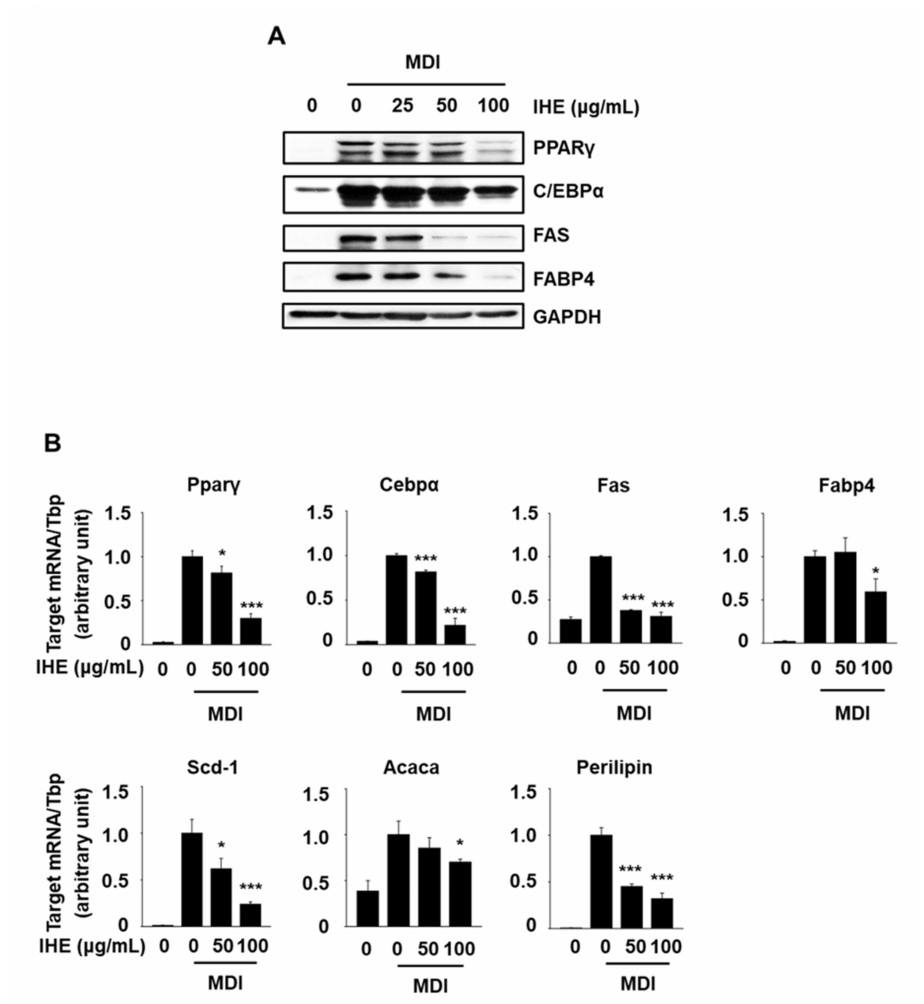
Figure 5. Effects of IHE on the expression of adipogenic transcription factors and their target genes. ( A , B ) Cells were treated with IHE for 6 days and protein and mRNA levels were determined by Western blot and qPCR analyses, respectively; * p < 0.05, *** p < 0.001 vs. MDI alone.